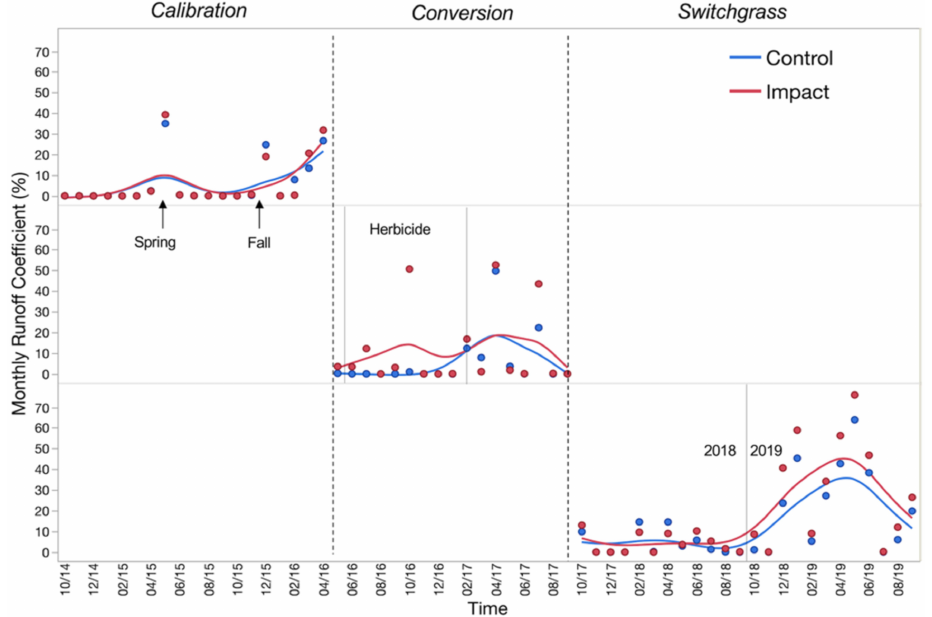
Figure 3. Comparison of monthly runoff coefficients between the Impact Watershed and the Control Watershed for each